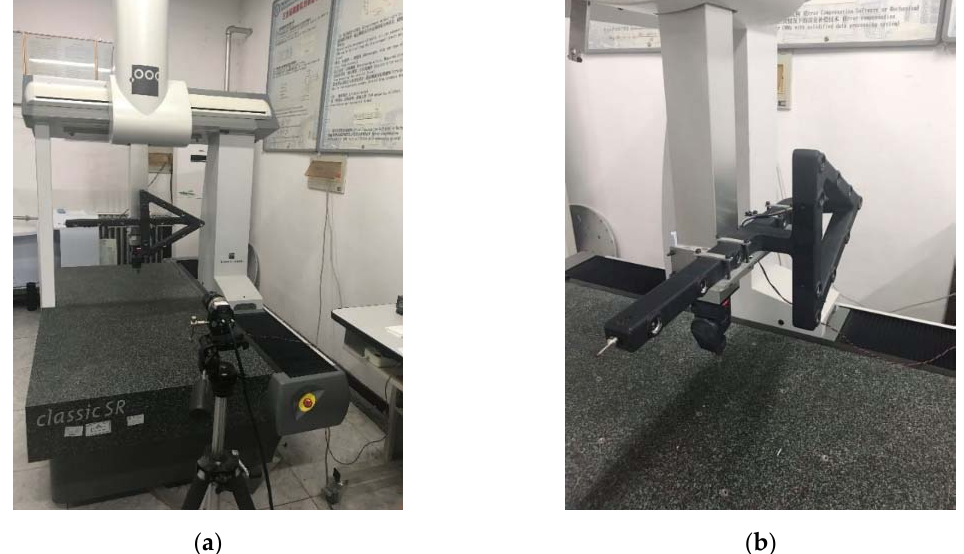
Figure 4. Actual experiment of control point position calibration: ( a ) The scene of one actual experiment; ( b ) the customized fixture to fasten light pen.